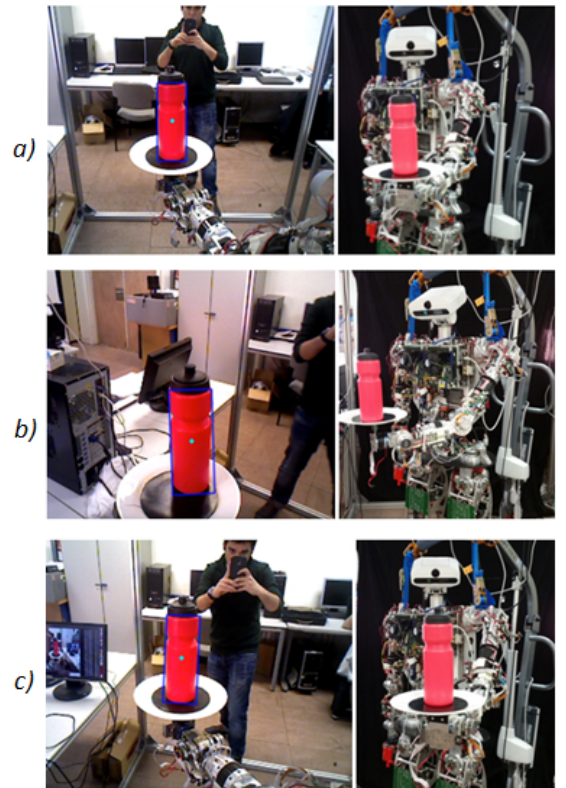
Figure 15. Second experiment. Positioning the bottle in different inclination angles and positions. ( a ) Bottle at robot left side (inclination 87 degrees); ( b ) Bottle at the front of the robot (inclination 90 degrees); ( c ) Bottle at robot left side (inclination 90degrees).